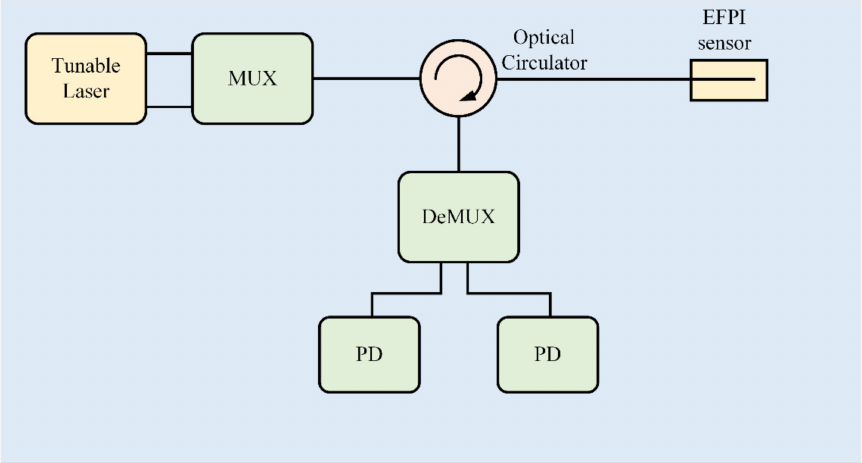
Figure 1. System schematic of dual wavelength demodulation system. MUX: multiplexer, DeMUX: demultiplexer, PD: